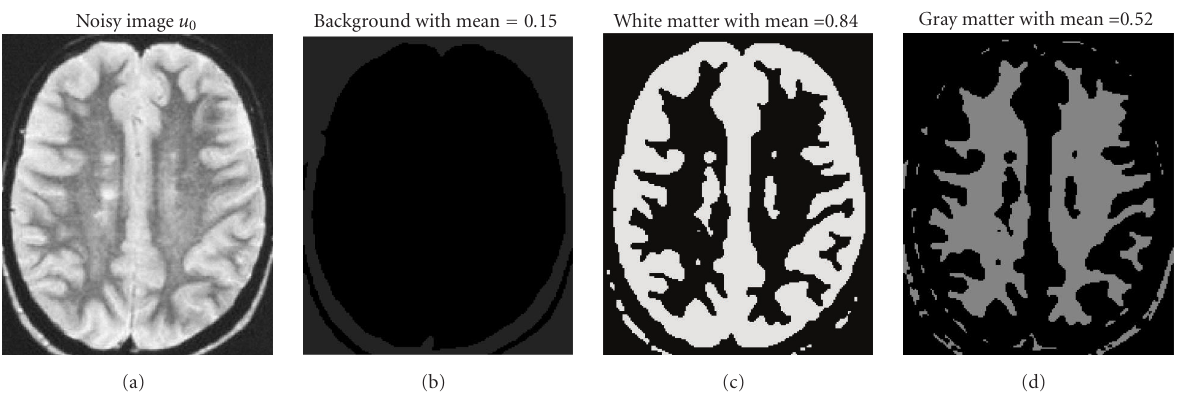
Figure 6: A brain image with low noise: hard segmentation from the SMS model via “hardening” formulae (5) and (6). Notice how the detailed branching of the gray matter has been successfully resolved by the